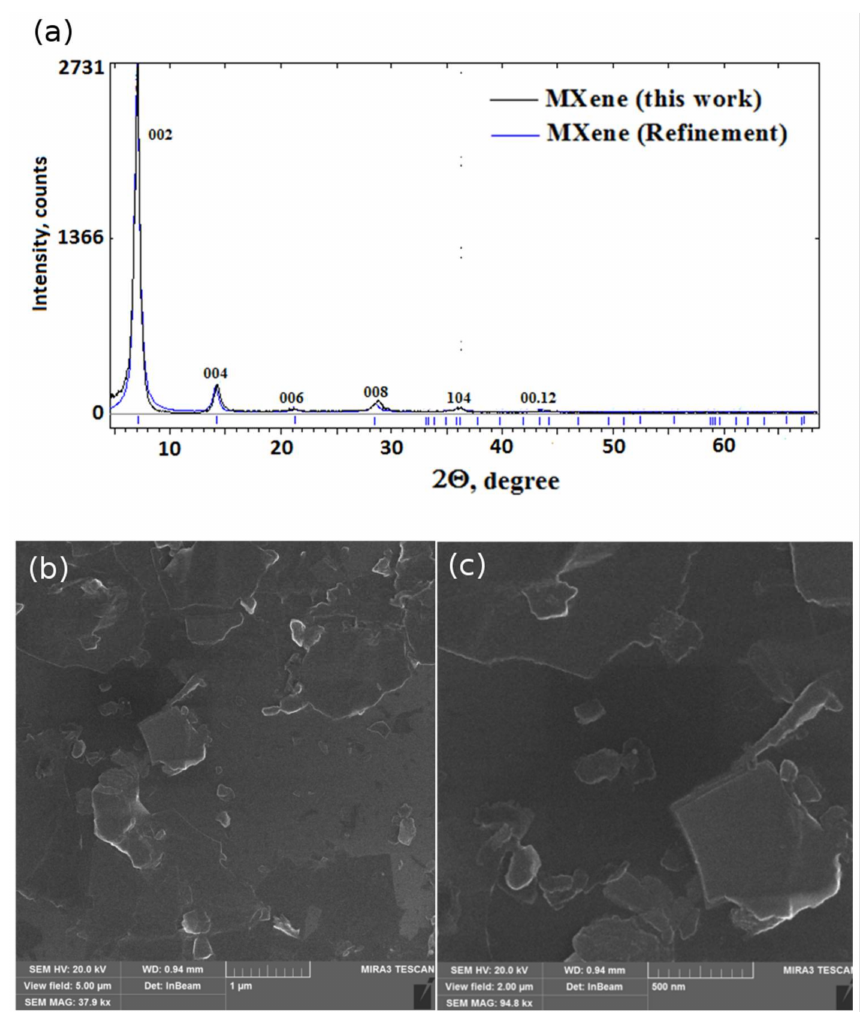
Figure 4. XRD ( a ) and SEM ( b , c –different magnifications) analyses of the prepared